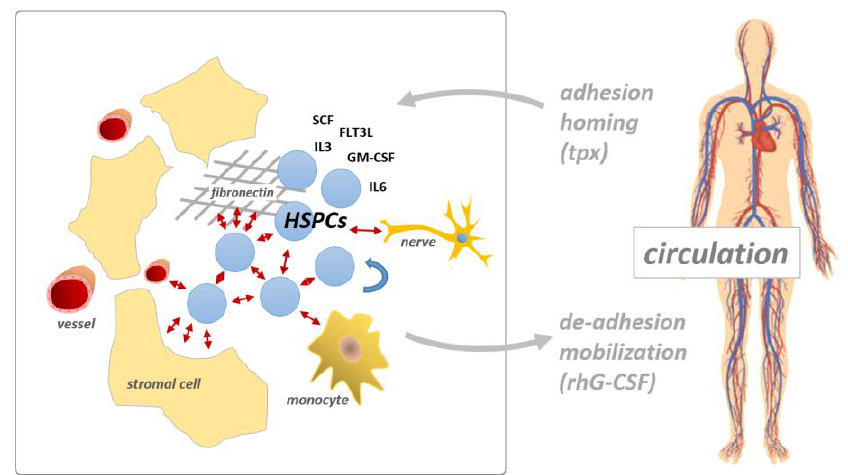
Figure 2. Adhesion molecule-mediated cell–cell interactions in the hematopoietic stem cell niche. Hematopoietic stem and progenitor cells (HSPCs) are able to assemble homotypic and heterotypic cell–cell and cell–matrix interactions (red arrows), via cell adhesion molecules (CAMs), such as VLA-4, VLA-5 and LFA-1, thereby regulating proliferation, self-renewal and differentiation. tpx, transplantation; rhG-CSF, recombinant human G-CSF.